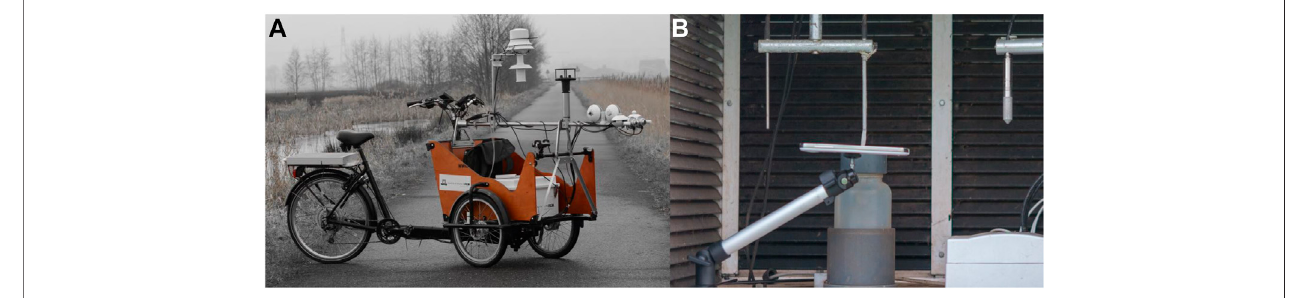
FIGURE 1 | The measurement cargo tricycle (A) and the smartphone setup in the Stevenson screen at the Veenkampen weather fi eld (B) . The smartphone is positioned horizontally with minimum contact points to prevent conduction.